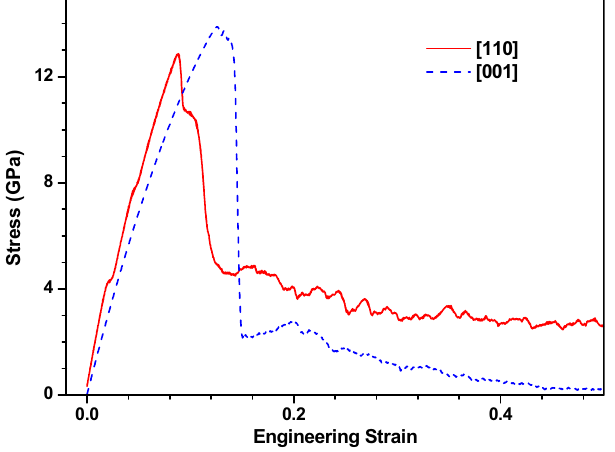
Figure 6. Stress-strain curves of 〈 110 〉 and 〈 100 〉 crystal orientations under the tensile strain rate of 10 9 s − 1 at room temperature.